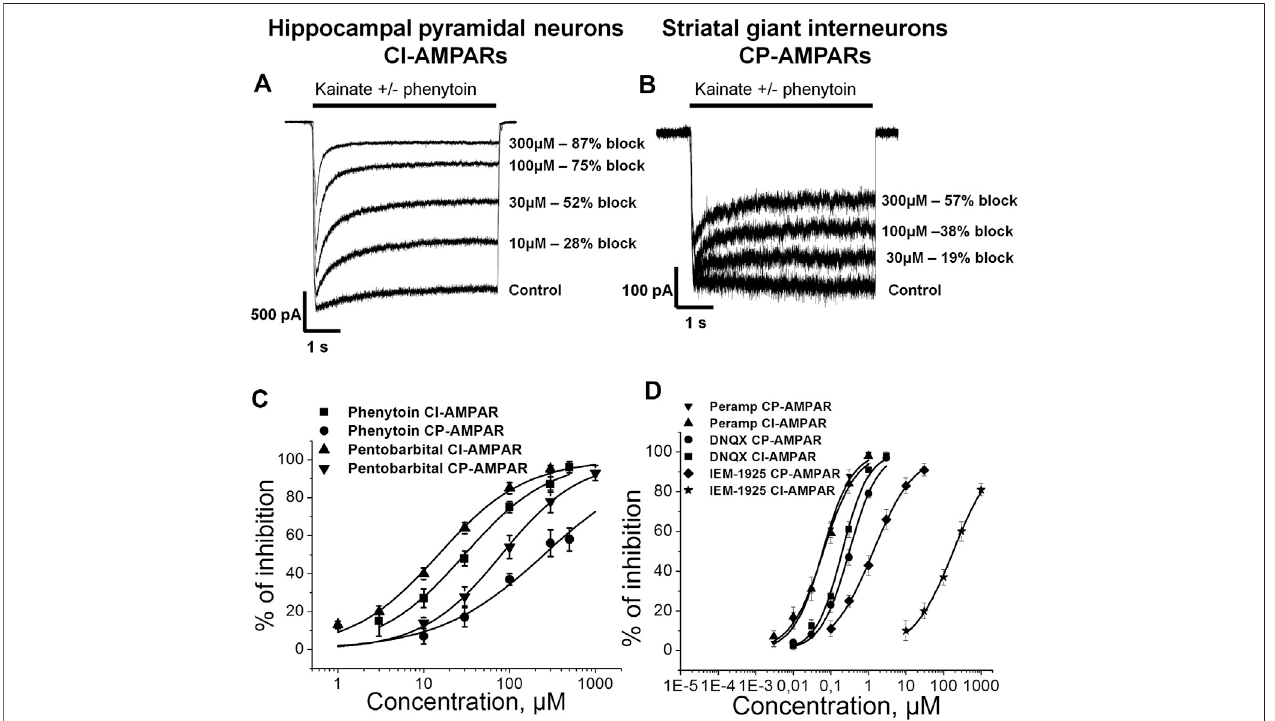
FIGURE 1 | Concentration dependence of action of phenytoin on calcium-impermeable and calcium-permeable AMPARs. (A,B) Representative examples of CI- AMPARs (A) and CP-AMPARs (B) inhibition by different concentrations of phenytoin. (C,D) Concentration-inhibition curves for phenytoin, pentobarbital (C) , and major AMPARs antagonists (D) .